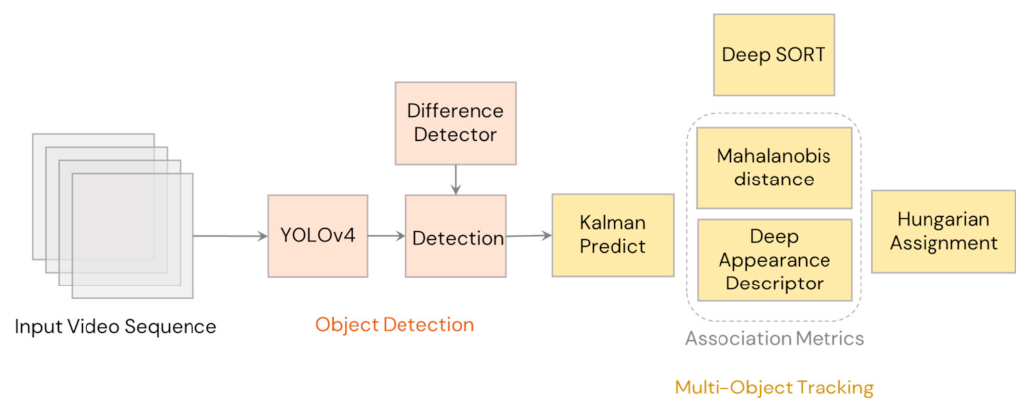
Figure 2. Architecture of Deep SORT (Simple online and real time tracking with deep association